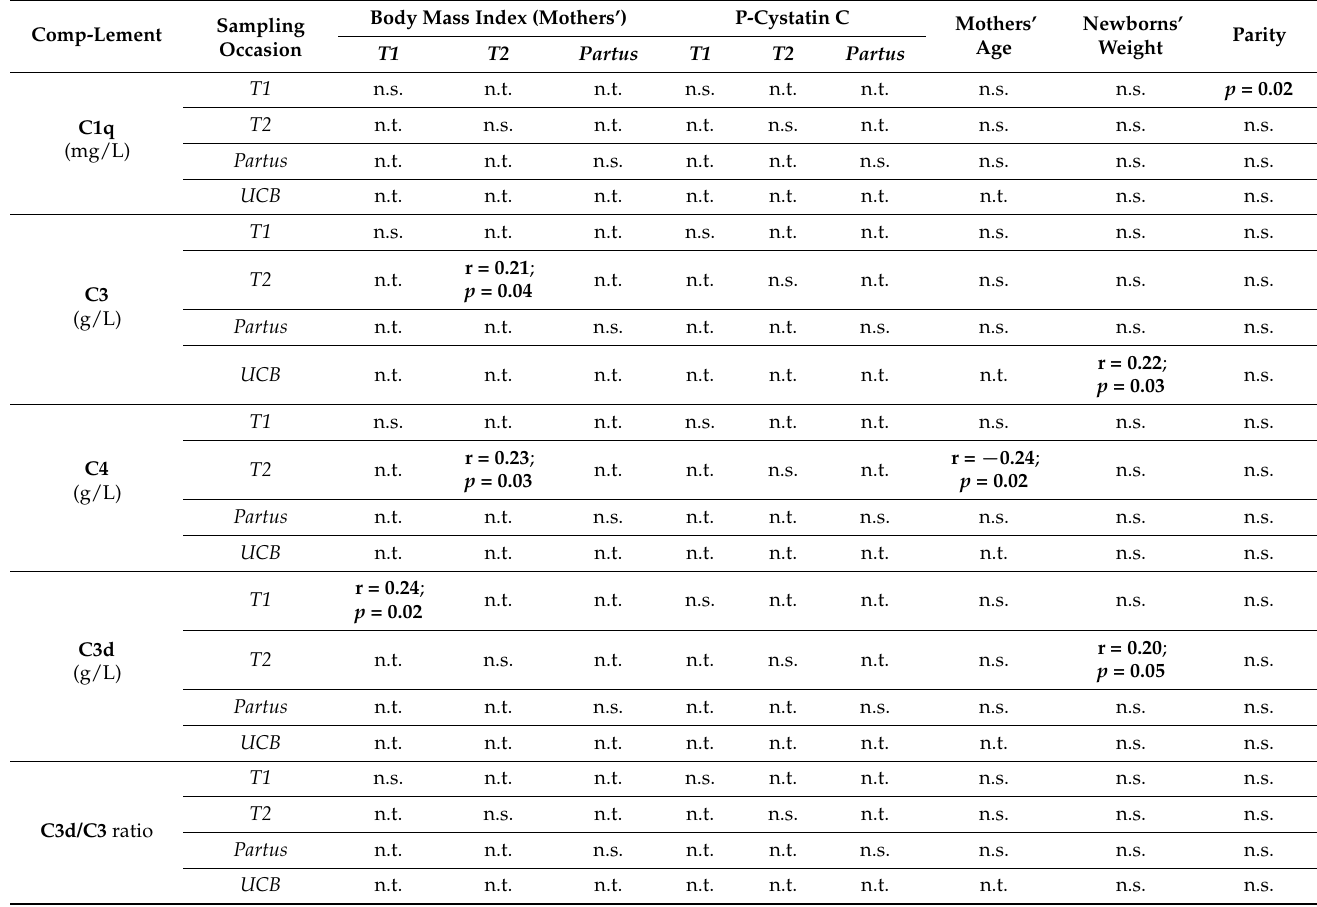
Table 3. Associations between complement protein levels and studied